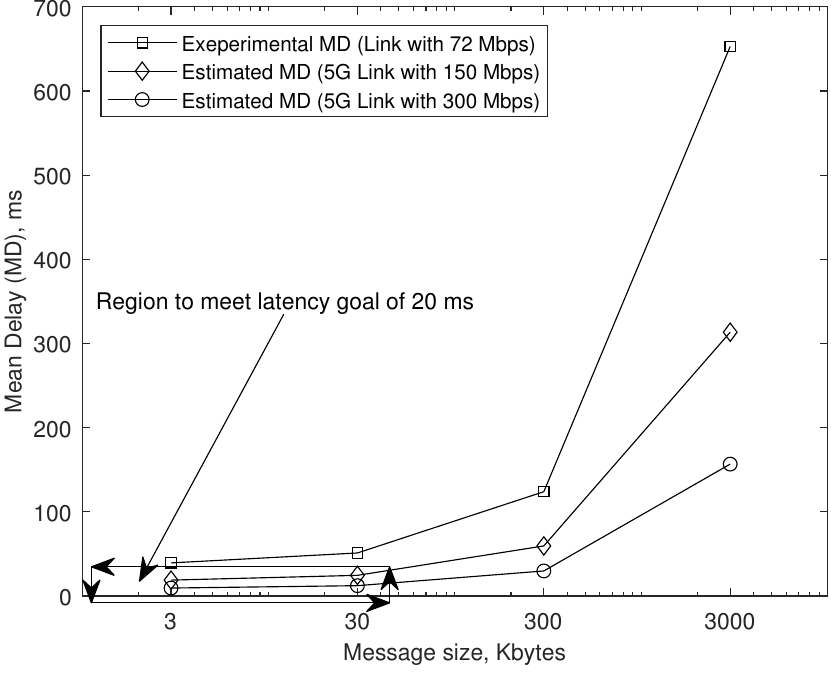
Figure 11. Estimated communication latency under the SGS scenario in 5G